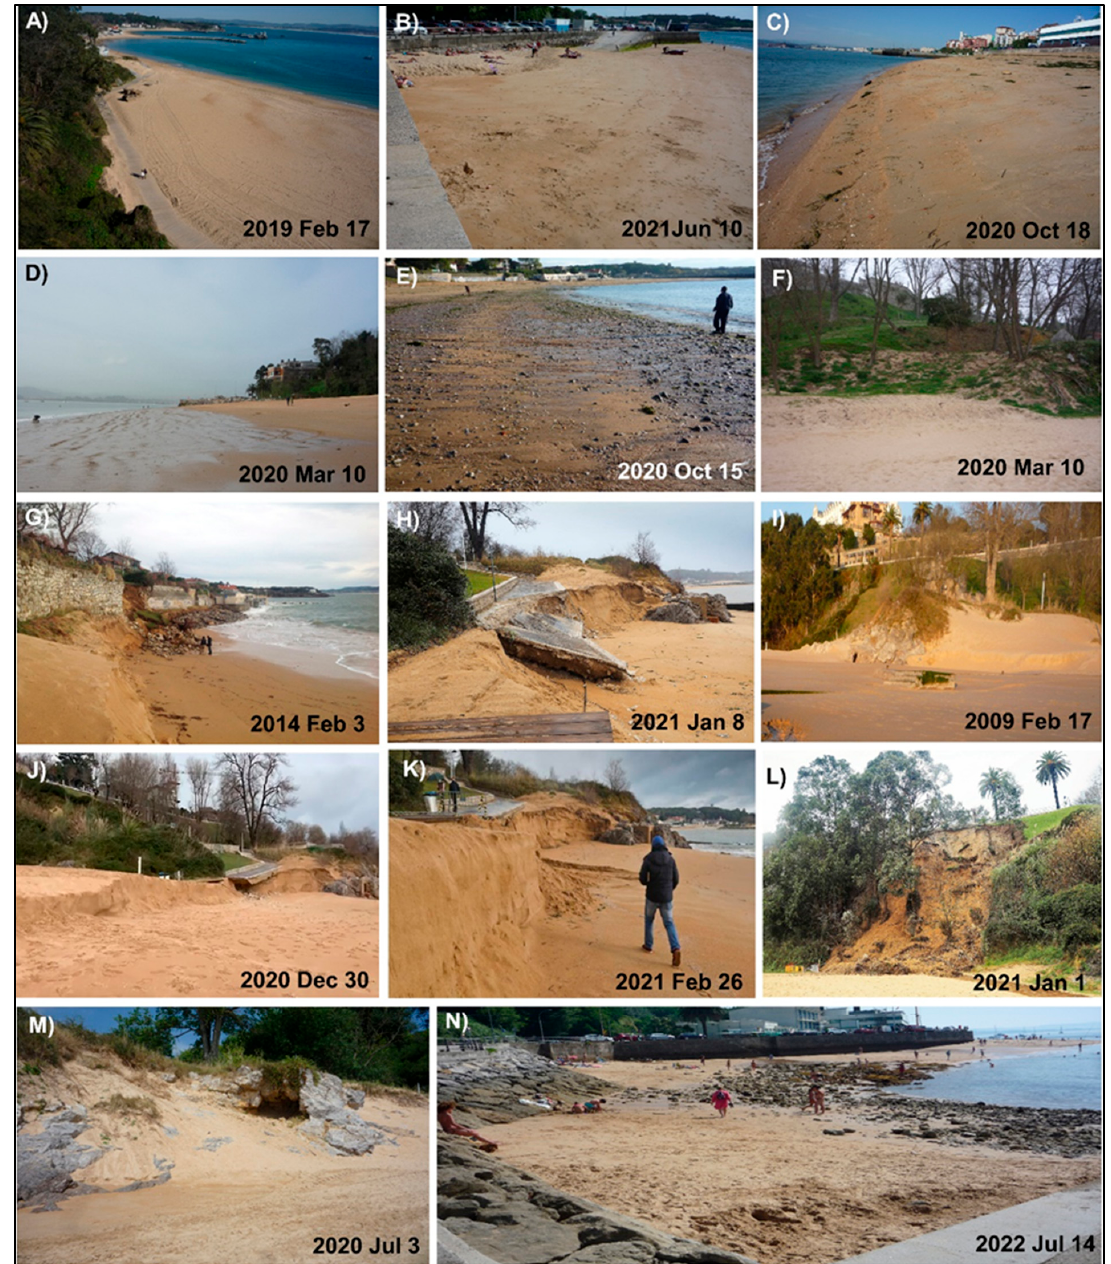
Figure 11. ( A ) The broad artificial berm at Los Peligros beach, affected by storm floods. In the background is the breakwater built in 2018. ( B ) Small upper beach of La Fenómeno after a storm. ( C ) Sand lobe migrating westward (background). ( D ) Sand prism built in the foreshore (wet belt) after a wave storm. ( E ) Lower intertidal beach (western half of La Magdalena). The angular gravels have concentrated due to strong washing by beach drift. ( F ) Partially vegetated climbing dunes (W La Magdalena). ( G ) Destructive effects in La Magdalena beach in 2014. ( H ) Accesses destroyed during the storm in January 2021 in Los Peligros. ( I ) Active climbing dunes on both sides of San Marcos Point (grey limestones), with an erosion scarp. ( J ) Erosive scarps in the upper foreshore of Los Peligros and strong erosion on the climbing dune. ( K ) Detail of the escarpment up to 2 m, after two months with respect to the previous H. ( L ) Landslide developed at the cliff of Los Peligros (storm of December 31, 2021). ( M ) Intense erosion on the climbing dunes (W of La Magdalena). ( N ) New beach of Gamazo. Rocky cove has begun to be filled with migrating sands, since summer 2021, from La Fenómeno (view from the west side).